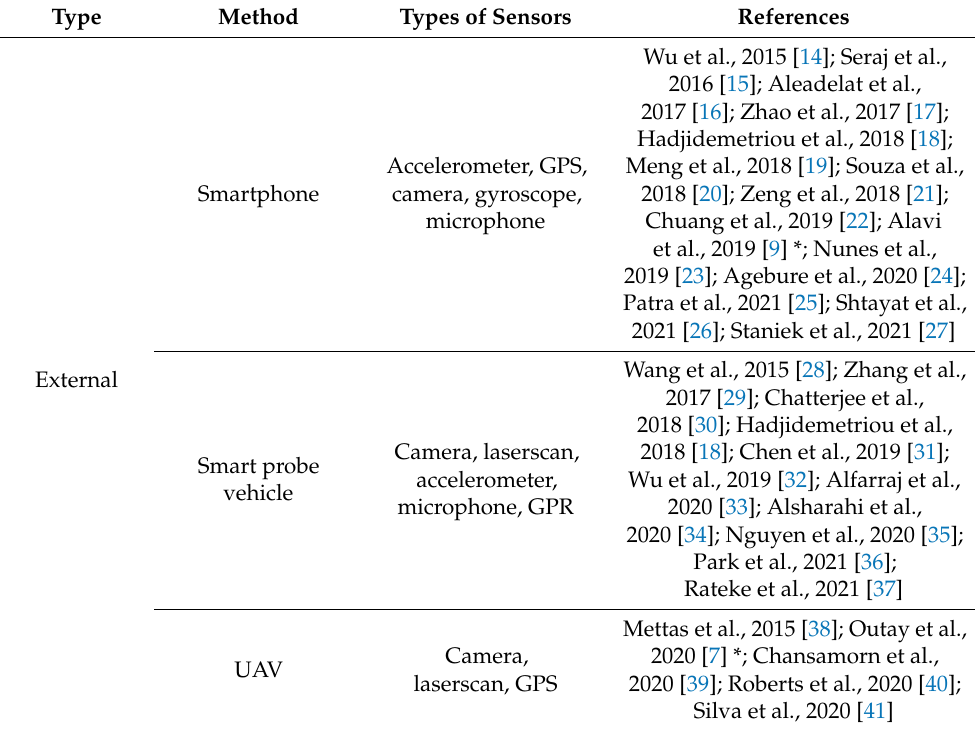
Table 2. Classification of research developments by data collection